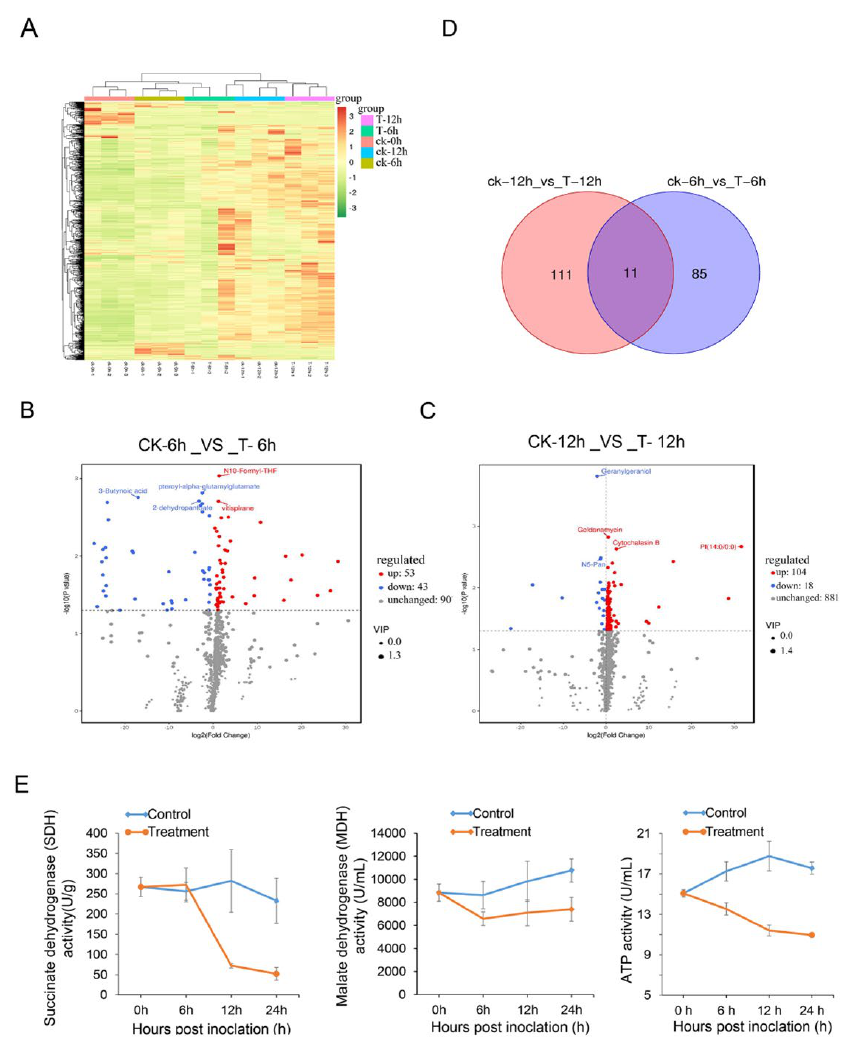
Figure 5. Effect of Streptomyces sp. Y1-14 on secondary metabolism of Foc TR4. ( A ) Heatmap based on the metabolome data of Foc TR4 treated with extracts of Streptomyces sp. Y1-14 at 0 h, 6 h, and 12 h. Three biological replications were carried out for analyzing the metabolite profiling. ( B , C ) Volcanic map of differential metabolites. Each dot represents a metabolite, the abscissa represents the group contrast ratio of each material change (with 2 logs base), the vertical ordinate represents the p - t test value (in the logarithm of 10 at the bottom), and the size of scatter represents the VIP value of the OPLS-DA model, the larger the scatter, the greater the VIP value; the differential expressed metabolites obtained by screening were more reliable. Blue dots in the figure represent downregulated DEMs, red dots represent upregulated DEMs, and grey dots represent no significantly different metabolites. In addition, the top 5 qualitative metabolites were selected and labeled in the figure after sorting by p value. ( D ) Venn diagram of the metabolite numbers. Ck-12 h vs. T-12 h represents DEMs of Foc TR4 treated with Streptomyces sp. Y1-14 extracts compared with the control at 12 h. Ck-6 h vs. T-6 h represents DEMs of Foc TR4 treated with Streptomyces sp. Y1-14 extracts compared with the control at 6 h. ( E ) Determination of enzyme activities of Foc TR4 after treatment with Streptomyces sp. Y1-14 extracts.